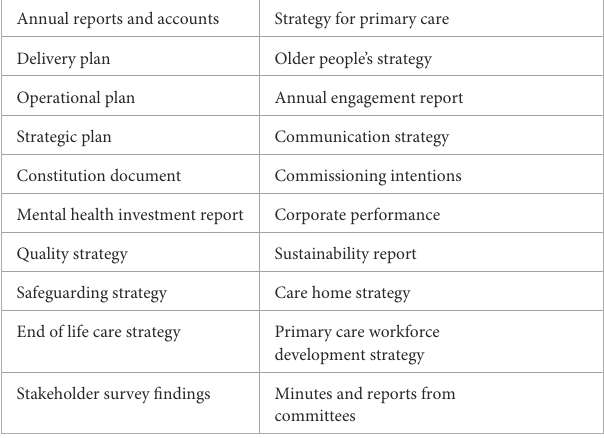
TABLE 1 Examples of Greater Manchester policy documents sourced from CCG and local authority